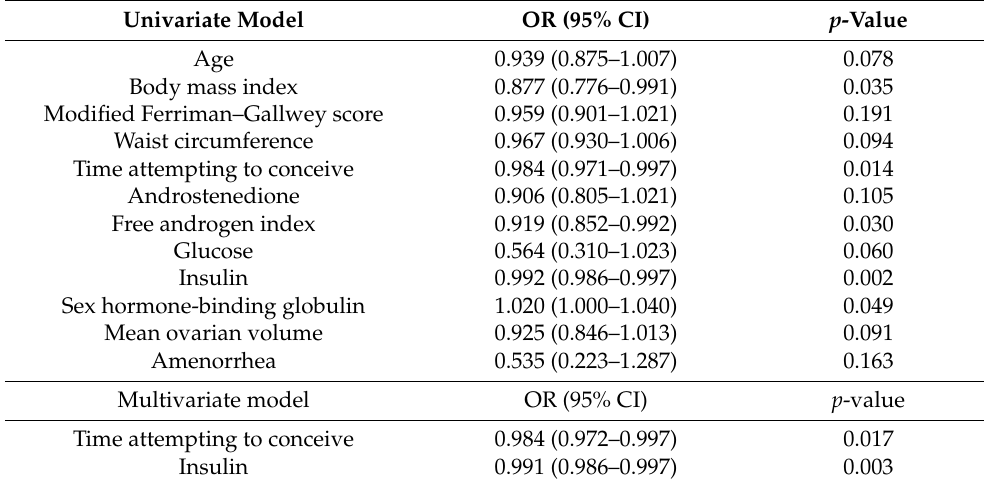
Table 3. Determinants of conception within 24 months after the start of the intervention.